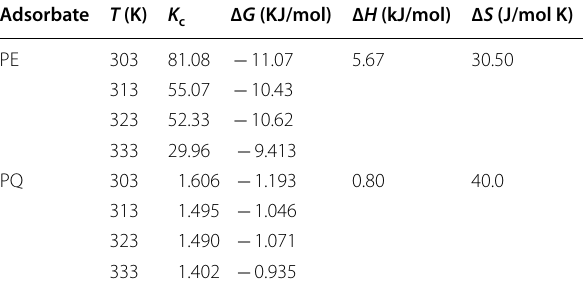
Table 3 Parameters for thethermodynamic adsorption of pendimethalin (PE) and paraquat dichloride (PQ) onto ACBGNS Adsorbate T (K) K c